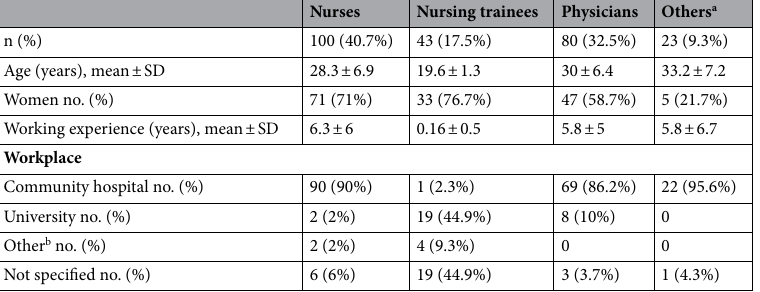
Table 1. Demographic and workplace characteristics. Others a : Health promoters, dentists and psychologists. Others b : Mobile Health Units, currently